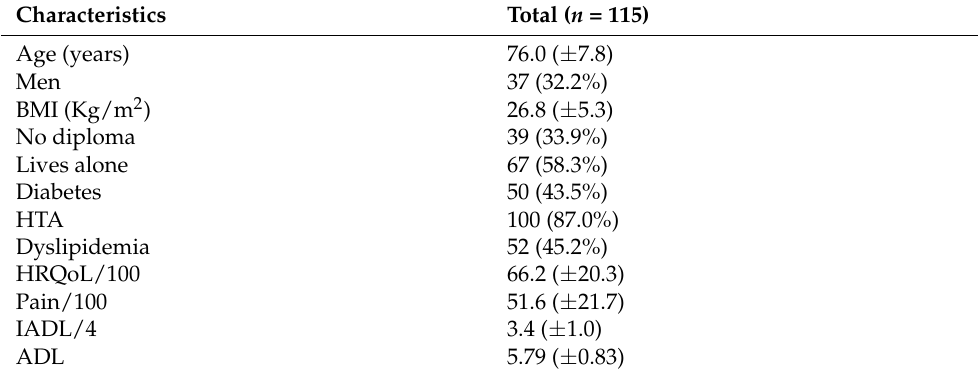
Table 1. Baseline characteristics of study participants—KASADS. Characteristics